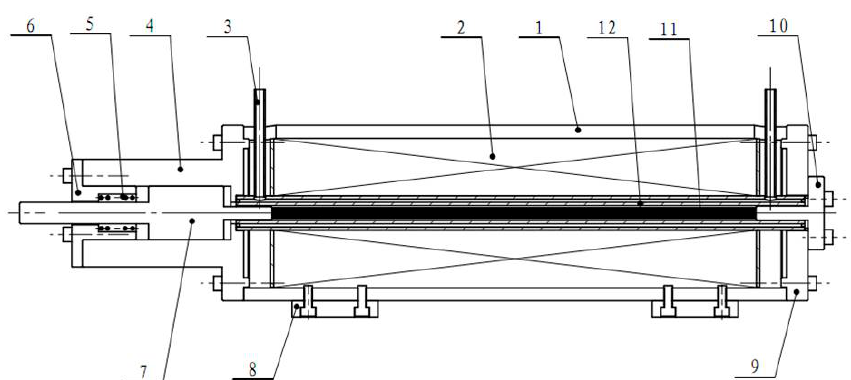
Figure 2. Structural diagram of giant magnetostrictive actuator with non-uniform coils. 1. shell; 2.